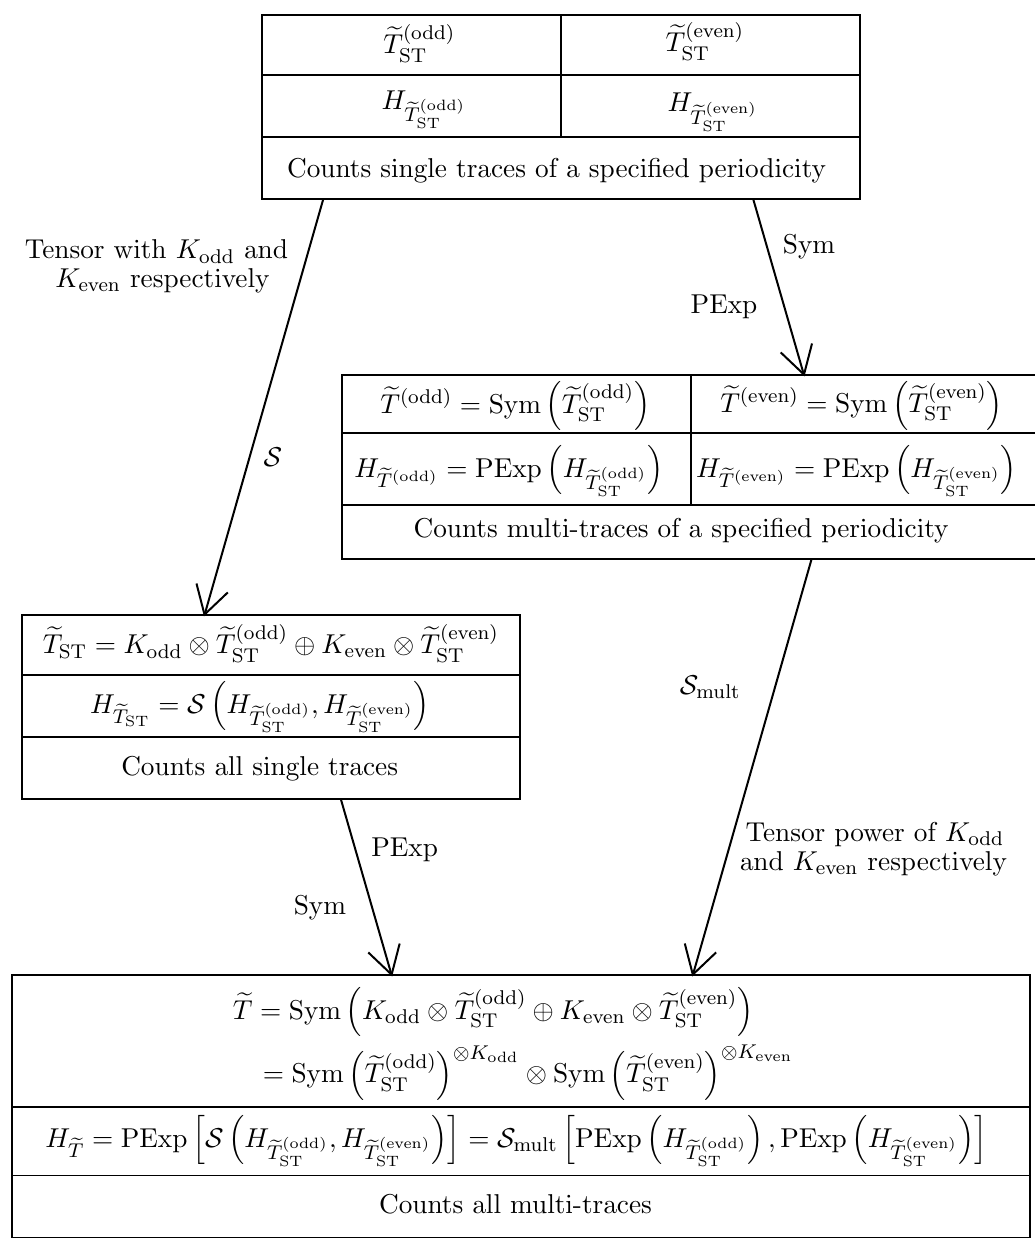
Figure 9 . Diagram summarising the structure of e T , the space of SO( N ) multi-traces, and its relation to e T (odd) , the space of SO( N ) single traces with a speci(cid:12)ed odd number of periods, and ST (even) e T